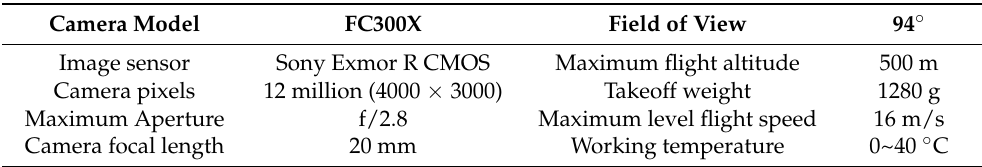
Table 1. Basic Phantom-4-pro drone parameters.